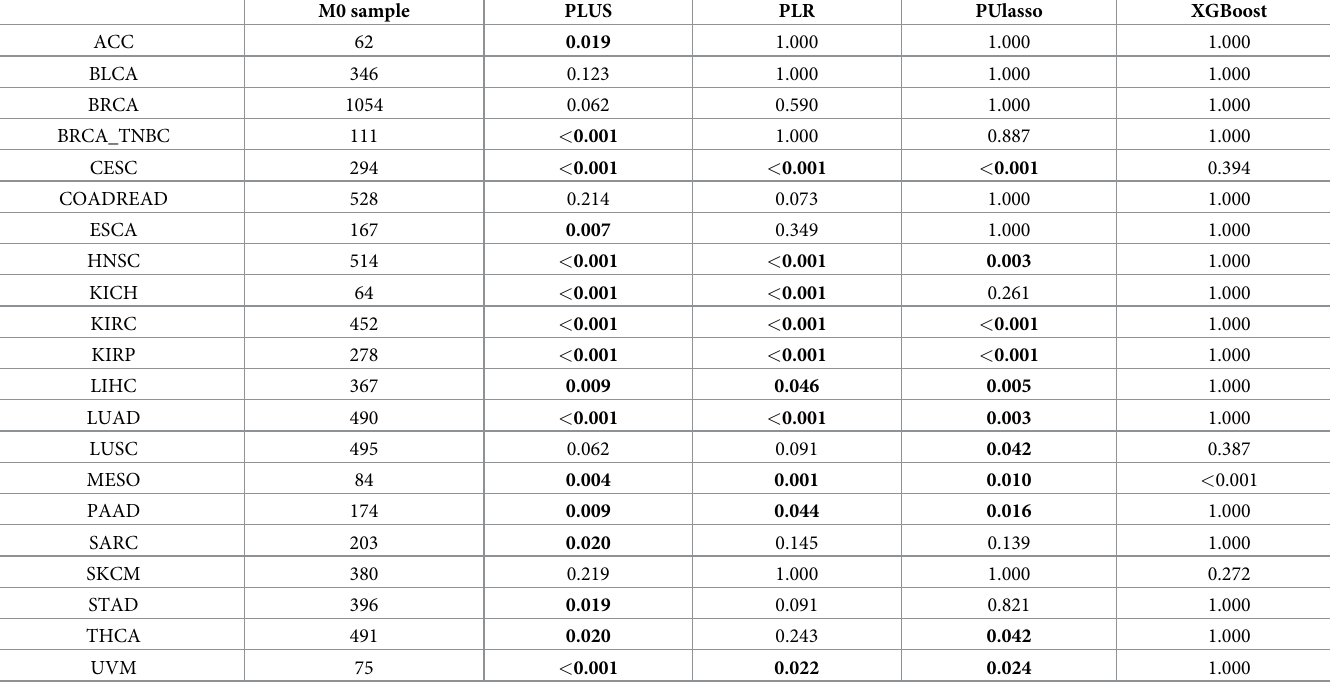
Table 1. Significance of the association between PFS and metastasis potential predicted by PLUS (column 3), PLR (column 4), PUlasso (column 5) and XGBoost (column 6) using only the patient samples not diagnosed as metastatic (M0 samples). The p -values are adjusted for multiple comparisons. The second column shows the number of M0 samples for each cancer